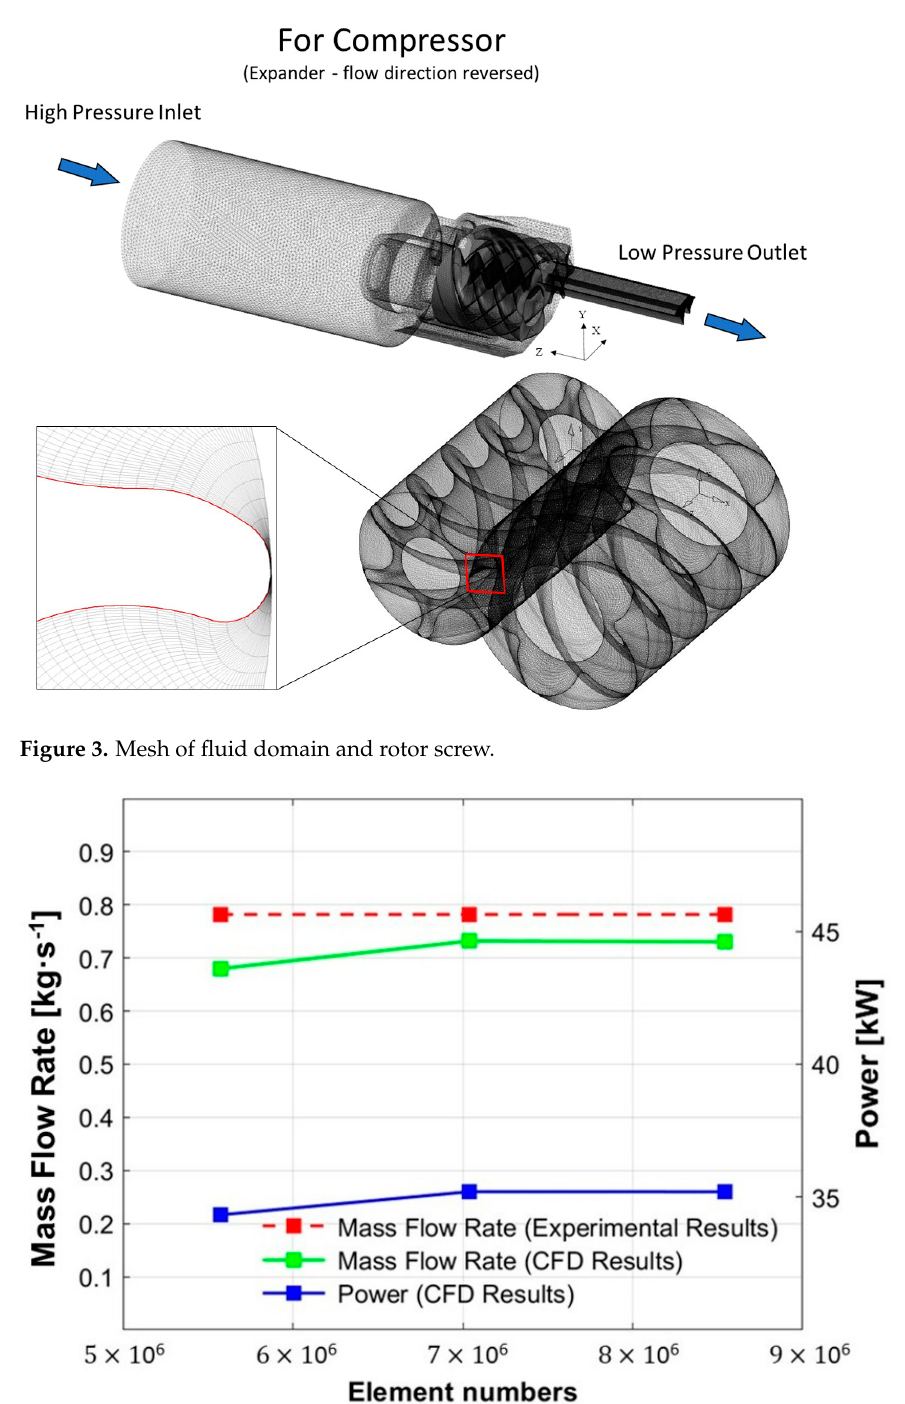
Figure 4. Mesh independence veri fi cation of mass fl ow rate and power.